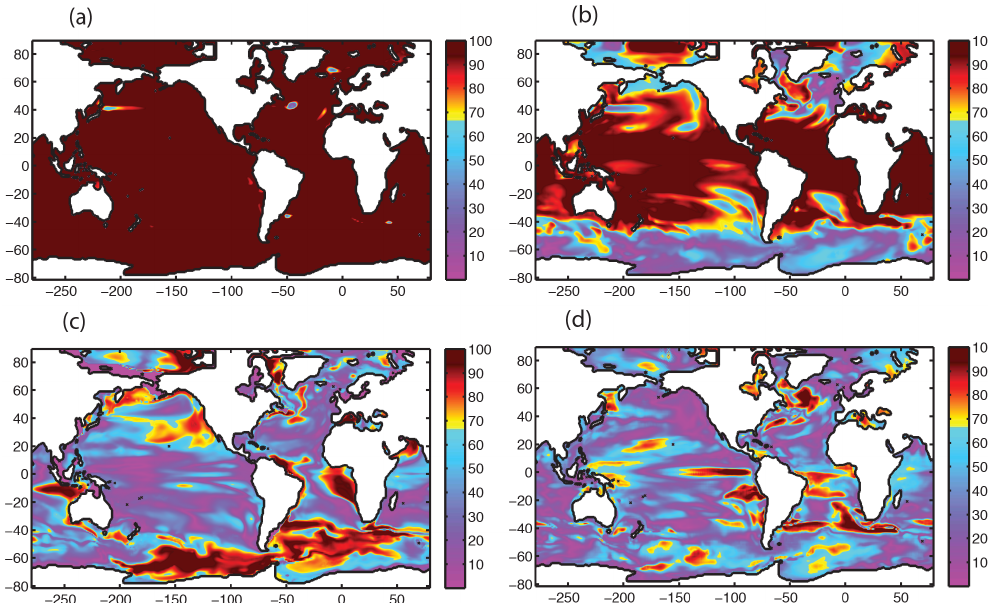
Figure 2. Confidence interval maps averaged over 2005–2014 for (a) (cid:127) arag , (b) SST, (c) O 2 inventories, and (d) NPP. For each case, a 30- year window has been used to calculated trends gridpoint by gridpoint for each year between 2005 and 2014. An average over 10 years was considered to remove shorter timescale fluctuations in the signal-to-noise ratio. Note that the color scheme here is chosen such that saturation occurs (maroon color) above the 67% confidence interval. Warm colors indicate confidence intervals ranging from 67–100% (more than one standard deviation), and cool colors span the range 0–67% (less than 1 standard deviation).